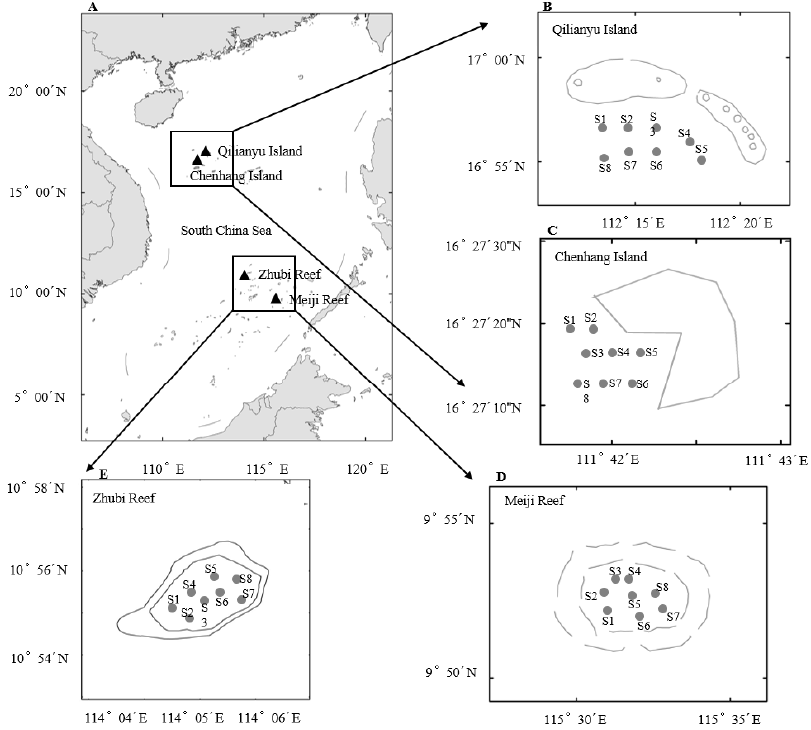
Figure 1. ( A ) Area map of the four islands and reefs in the South China Sea. ( B ) Qilianyu Island, ( C ) Chenhang Island, ( D ) Meiji Reef, ( E ) Zhubi Reef. ( C ) Chenhang Island, ( D ) Meiji Reef, ( E ) Zhubi